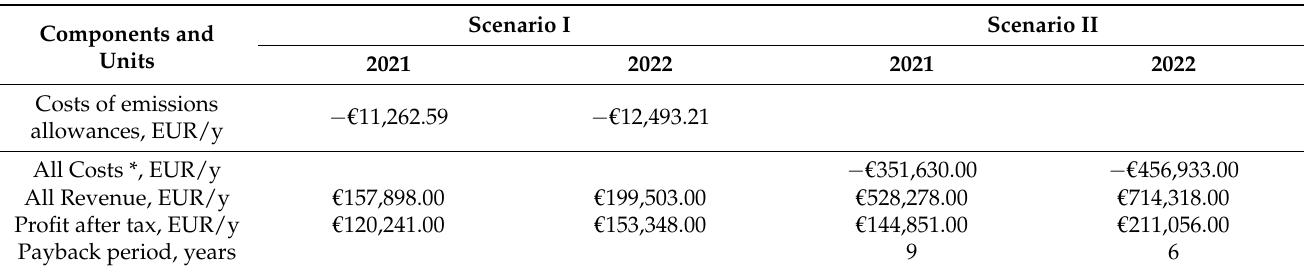
Table 10. Economic balance for Scenarios I and II in years 2021–2022–including CO 2eq emission allowances.